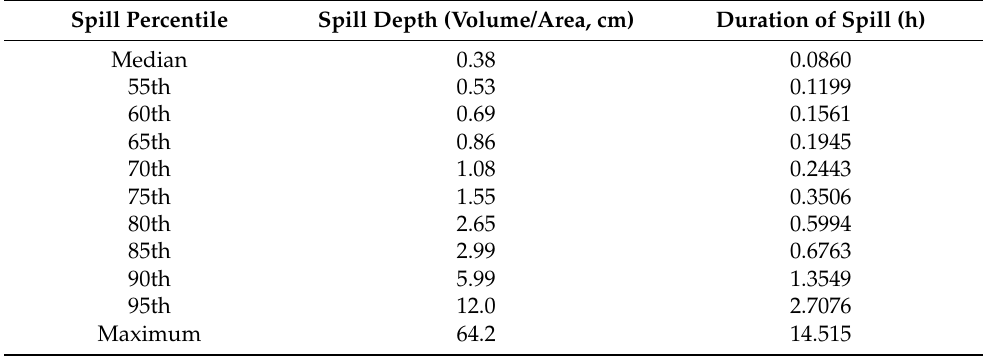
Table 1. Calculated spill volume per area (spill depth) and spill durations (model inputs) that correspond to a particular spill